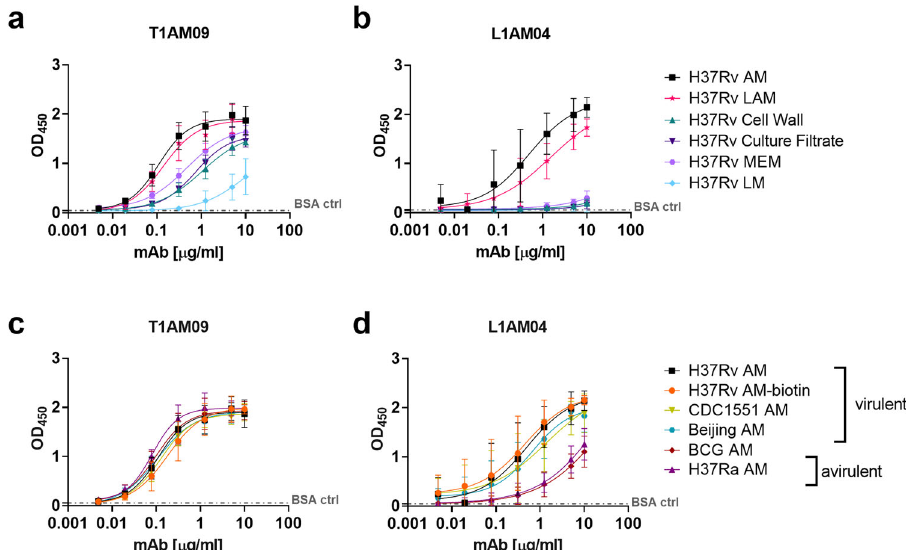
Fig. 2 Anti-AM cross-reactivity of T1AM09 and L1AM04 to Mtb components. Binding of mAbs assessed by ELISA to antigens and fractions isolated from H37Rv for a T1AM09, and b L1AM04, and to AM isolated from different Mtb strains for c T1AM09, and d L1AM04. Each data point represents the mean and standard deviation from two or more replicates. Dashed line represents the BSA